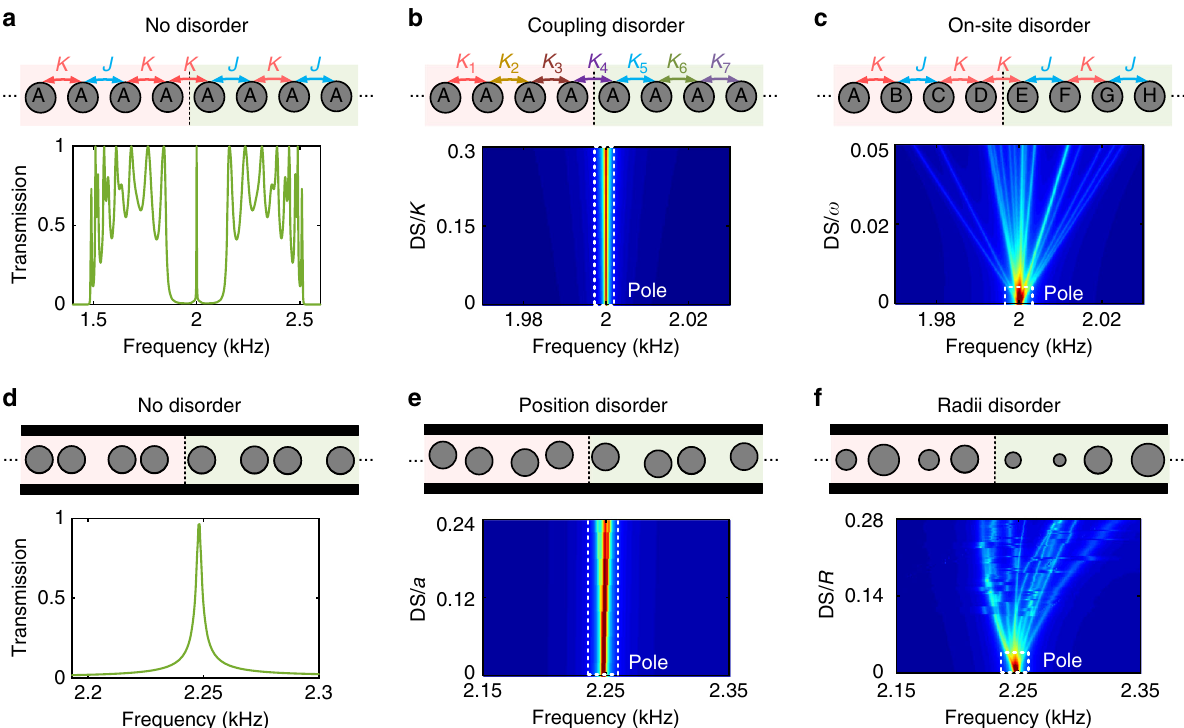
Fig. 3 Effect of various defect types on the topological equation solver . a A topological interface made from tight-binding SSH chains (top), consisting of resonators with resonance frequency ω 0 coupled to each other via detuned hopping amplitudes K and J > K , supports an edge mode protected by chirality. The transmission spectrum of the chain (bottom) shows a mid-gap resonance, which corresponds to the topological edge mode. b Some disorder is added to the hopping amplitudes of the system (top), which preserve chiral symmetry. The bottom panel demonstrates the robustness of the transmission peak (averaged over 20 realizations of disorder) as the disorder strength (DS) is increased. c Same as panel ( b ) except that the disorder is applied to the on-site potentials of the chain, hereby breaking chiral symmetry. The transmission peak is sensitive to arbitrarily weak disorder. d − f Same as ( a − c ) but for the proposed acoustic equation solver. The resonance line-shape of the edge mode is robust to the position movement (normalized to the lattice constant) of ¼ 1 (see Methods). In contrast, detuning the radii of the obstacles breaks the rods inside the waveguide (panel e ), which does not break the symmetry M 2 cell this property, and causes degradation in the performance of the equation solver (panel f